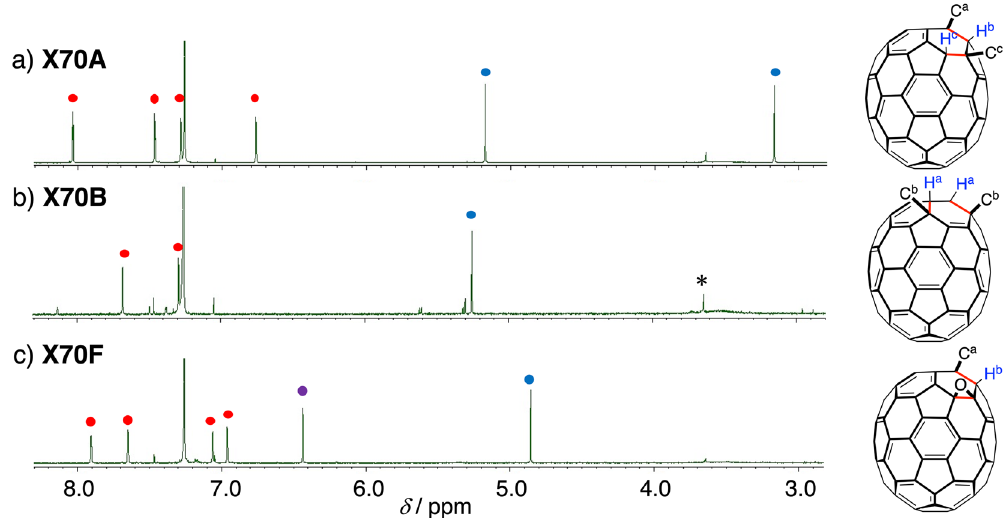
Figure 2. 1 H NMR spectra of a series of X70 n and illustration of the replacement positions on C 70 . ( a ) X70A in CDCl 3 , ( b ) X70B in CDCl 3 , and ( c ) X70F in CDCl 3 . * indicates an impurity peak. Red circles are assigned to the peaks of xanthene, blue circles are assigned to the peaks of the fullerene protons, and a purple circle is assigned to the peak of the hydroxy group. C a , C b , and C c represent the xanthene carbon atoms; H a , H b , and H c represent the hydrogen atoms attached to carbons a , b , and c , respectively. The structures of X70A , X70B , and X70F determined by the single-crystal X-ray analysis are shown in Fig. 3.